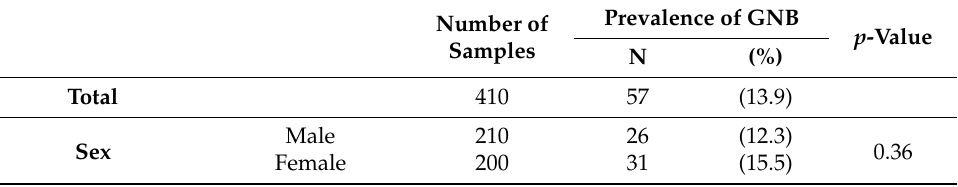
Table 1. Prevalence of aerobic Gram-negative bacteria (by age, sex, and district) isolated from the nasopharynx of healthy under-five children in Accra, Ghana, from September to December